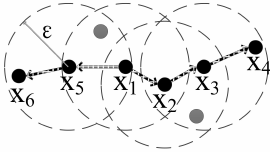
Figure A1. Basic notions of